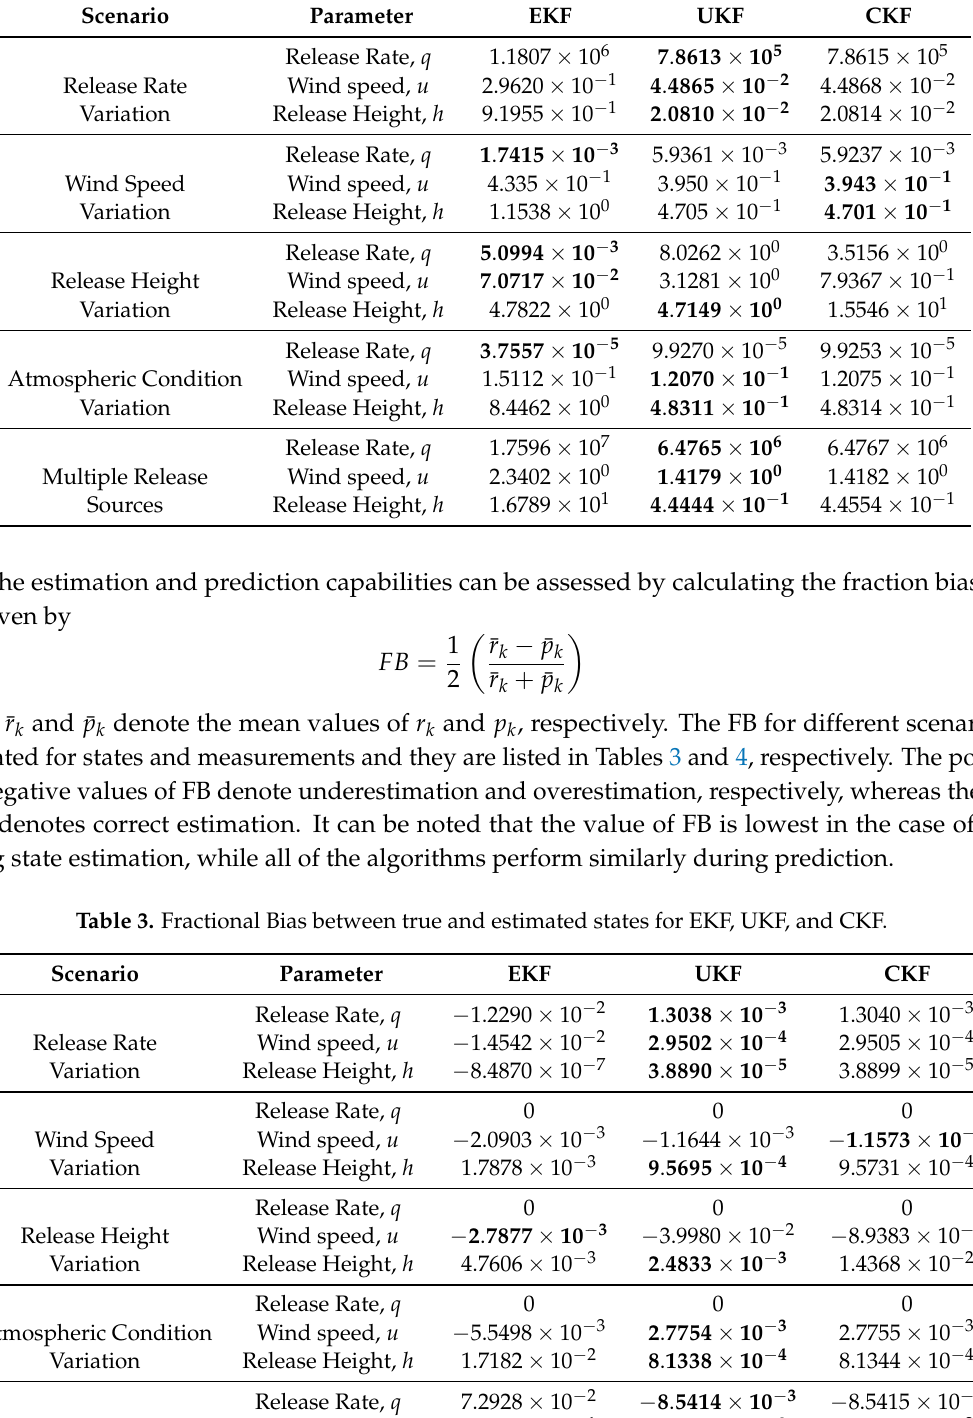
Table 2. Root mean squared error between true and estimated states for Extended Kalman Filter (EKF), Unscented Kalman Filter (UKF), and cubature Kalman filters (CKF).